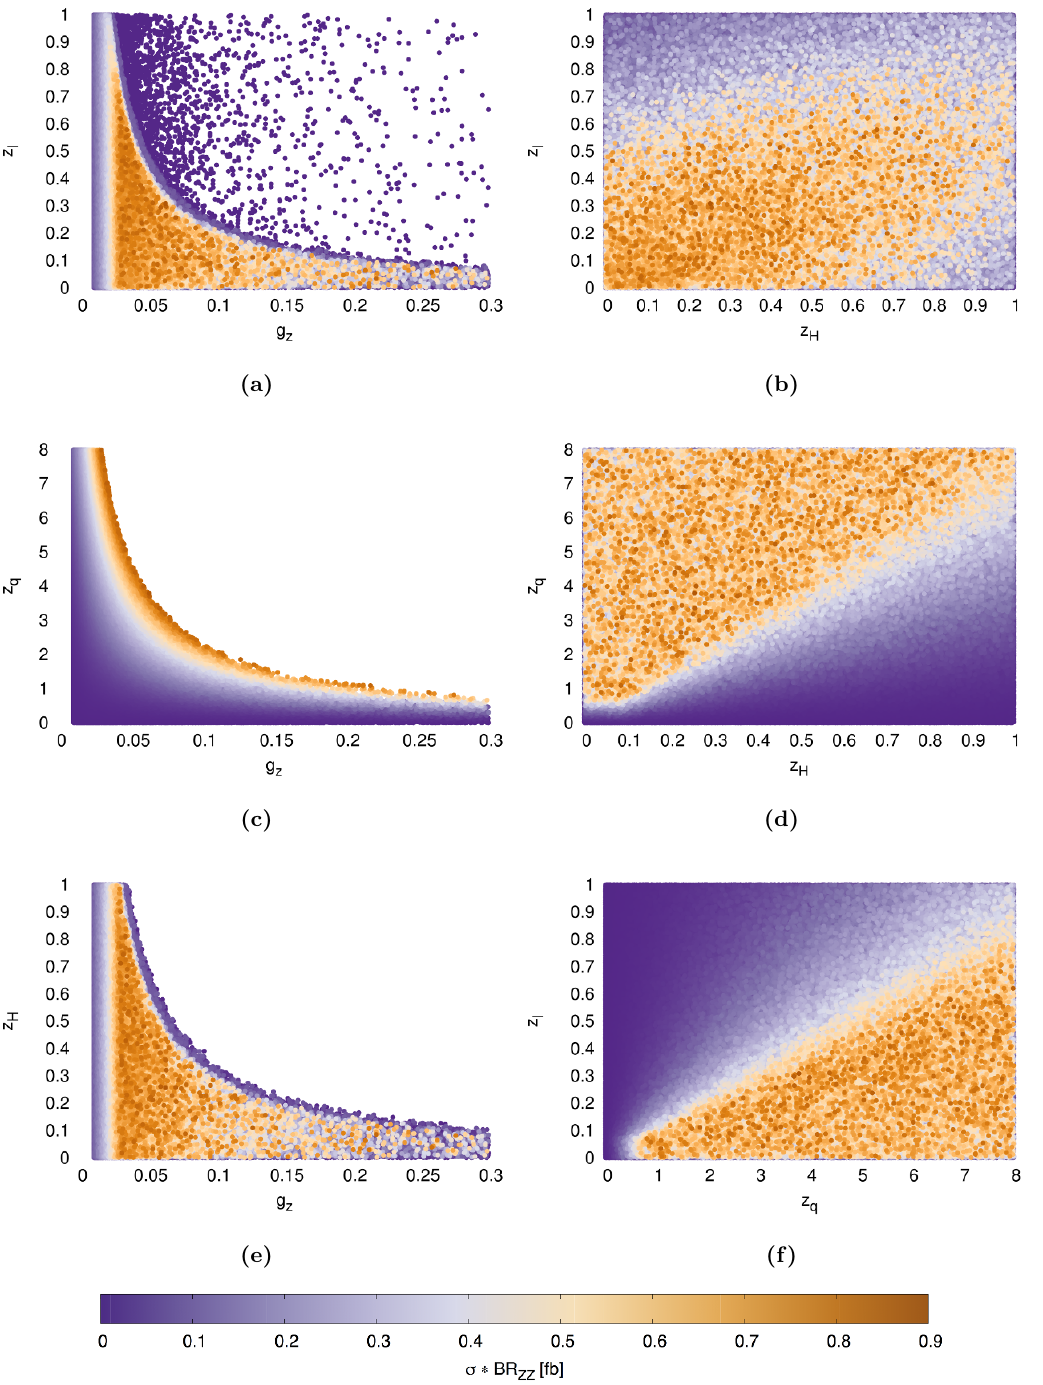
Figure 4. 2D heat maps of (cid:27) ( pp ! Z 0 ) (cid:2) BR ( Z 0 ! ZZ ) in fb against di(cid:11)erent combinations of the parameters g z ; z H ; z q and z ‘ obtained from a random scan of the 5-D volume de(cid:12)ned in eq. (5.2) and with points shown satisfying the experimental constraints considered in subsection 5.1.